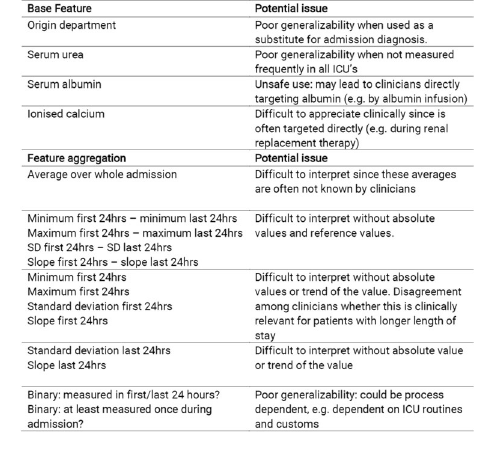
Table 1 (abstract 001497). See text for